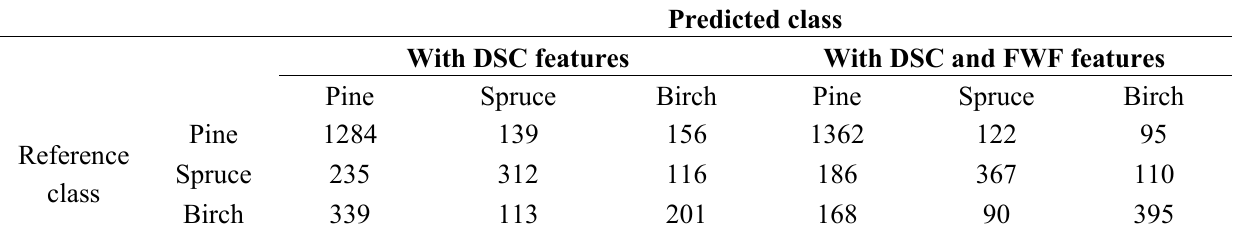
Table 4. Error matrix for the classifications using two sets of features.